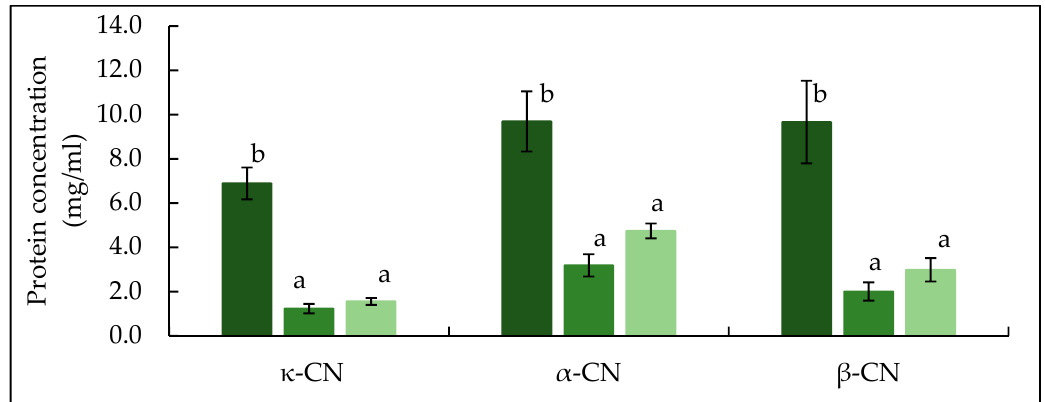
Figure 3. Concentration of κ - casein, α s -casein and β - casein in mTG crosslinked micellar casein concentrate feed used in microfiltration. CTR: no enzyme treatment ( ■) ; TA: 5 °C/24 h ( ■) ; TB: 40 °C/90 min ( ■). Different lower-case letters indicate significant differences ( p < 0.05) between proteins.